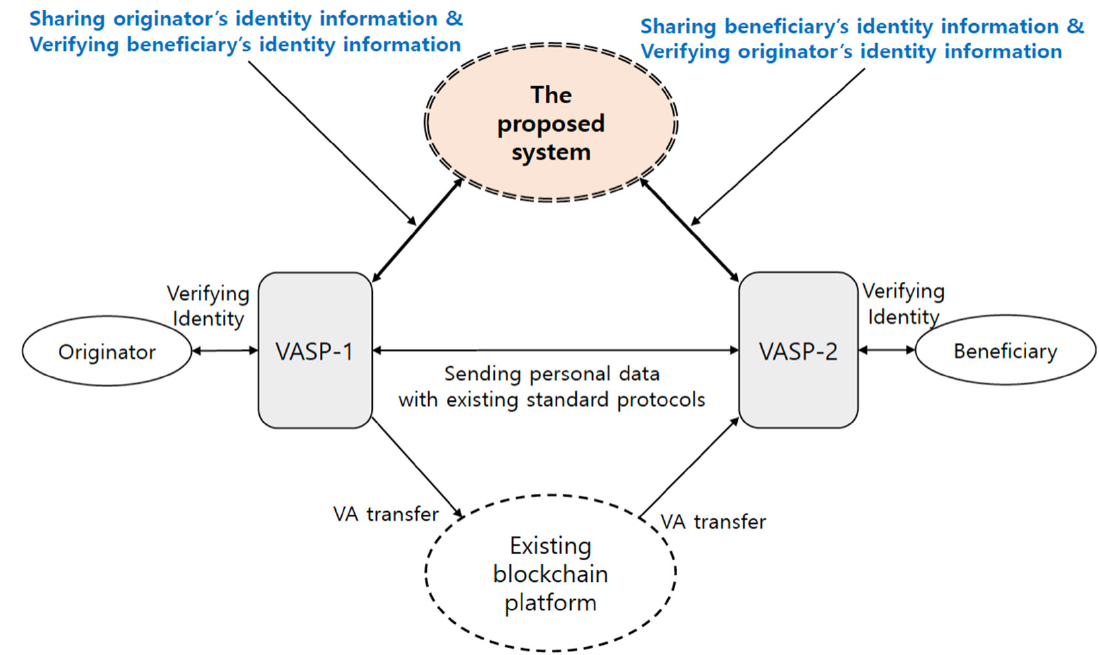
Figure 2. Service model for customer identification.